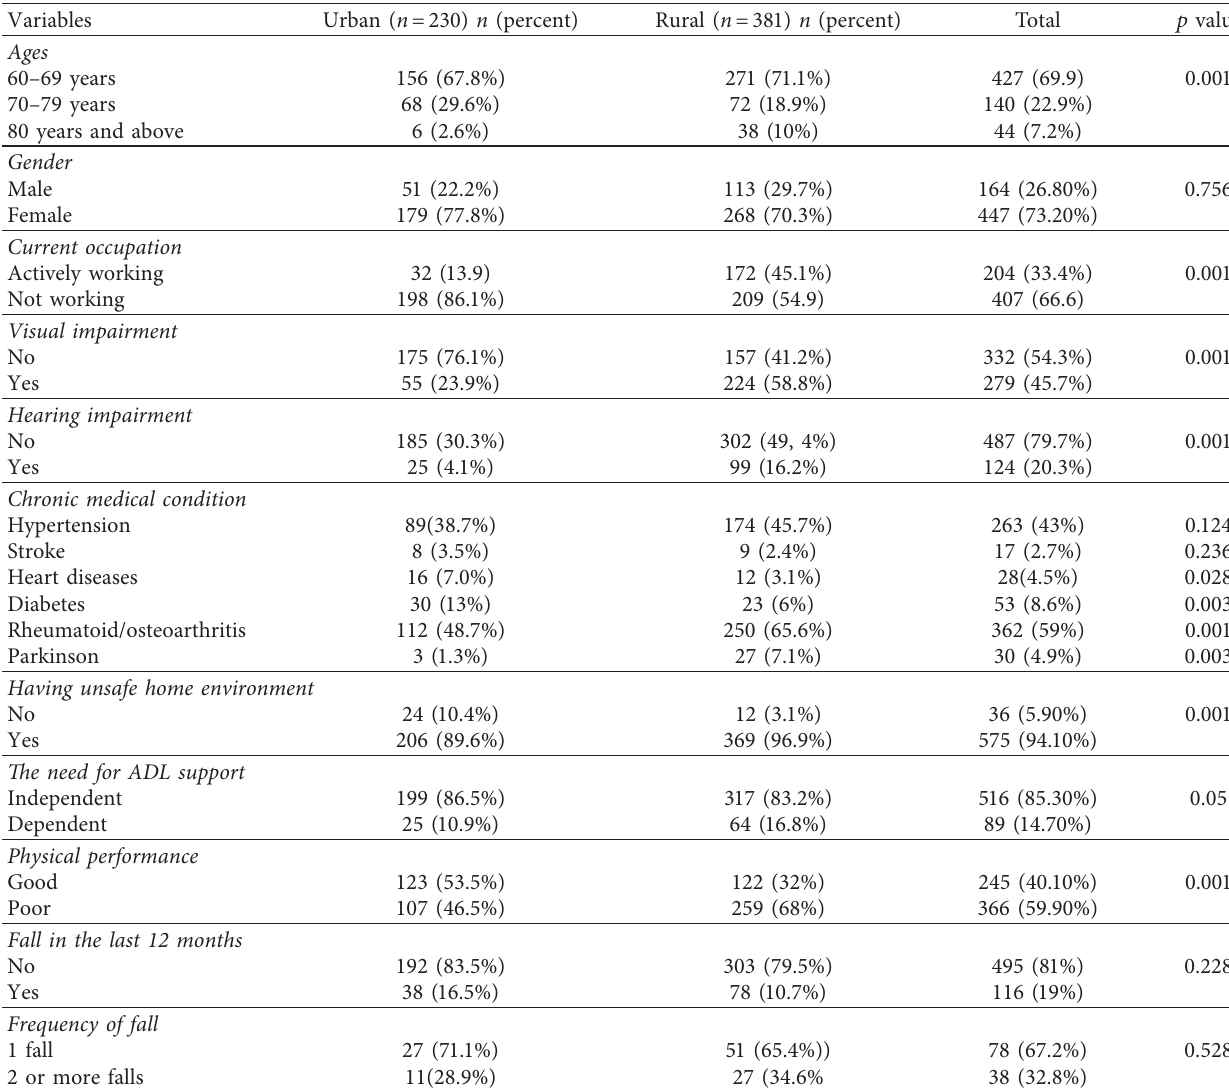
Table 1: Characteristics of study